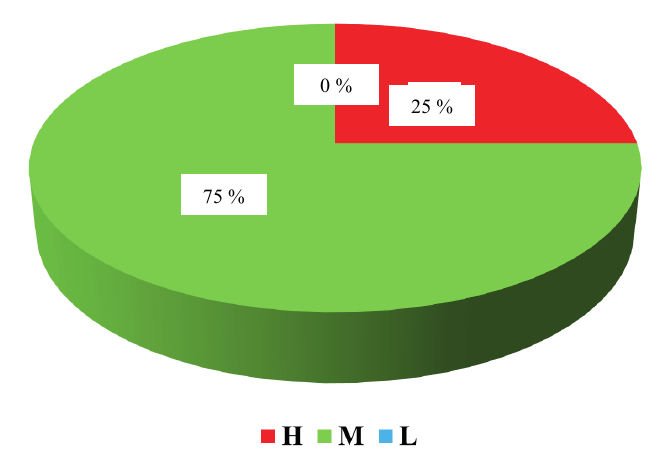
Fig. 6. Comparison of FMEA risk levels in the utilization